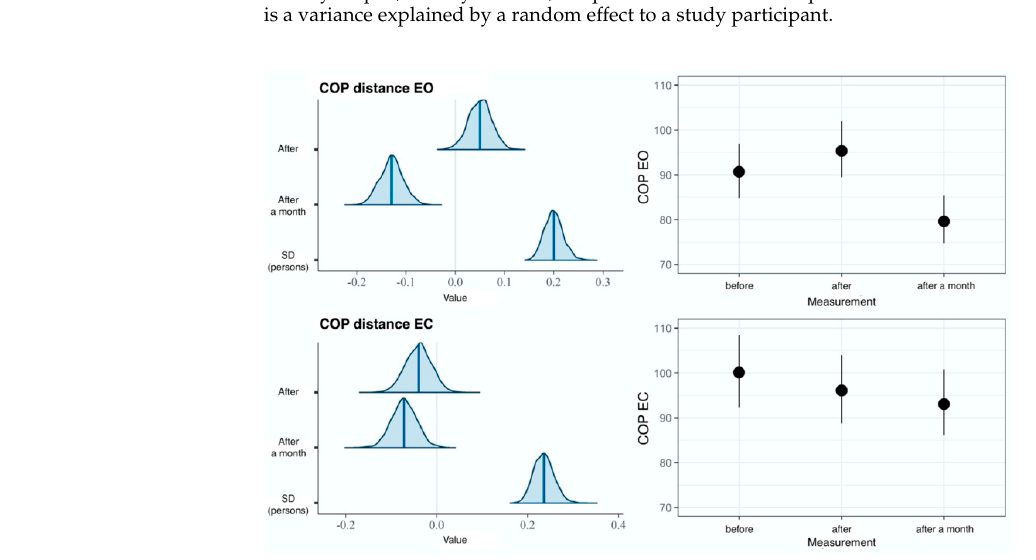
Table 2. Fitness of the regression models to the dataset used in this paper for testing differences between groups.